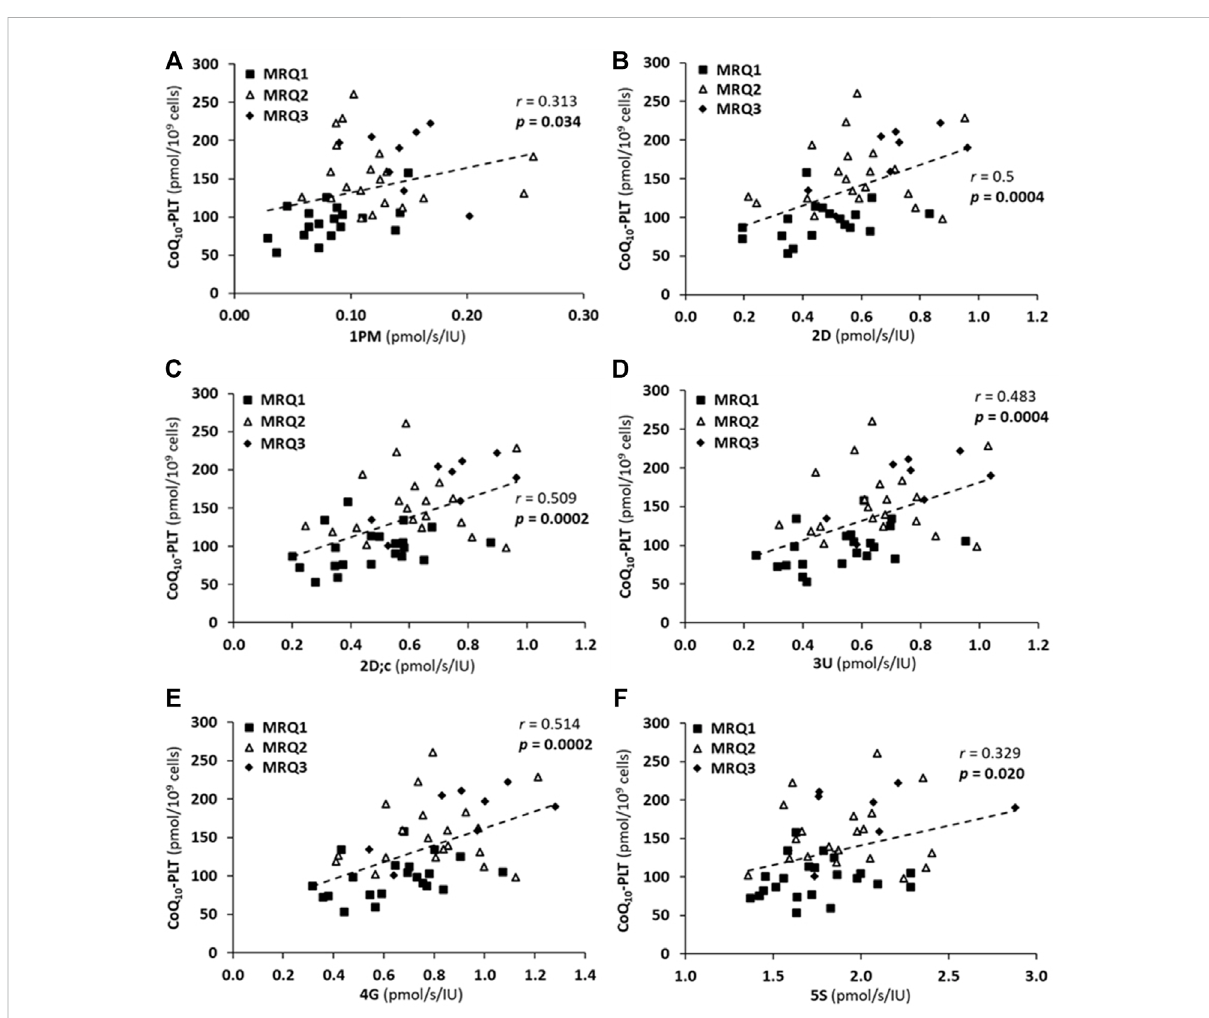
FIGURE 6 The correlations between CoQ 10-TOTAL concentration in platelets (CoQ 10 -PLT) and platelet mitochondrial respiration rates (A) 1PM, (B) 2D, (C) 2D; c, (D) 3U, (E) 4G, (F) 5S of patients with post C-19. The groups names and respiration rates labeling as for Figure 3. r — Pearson correlation coef fi cient; p -values show statistical signi fi cance of the